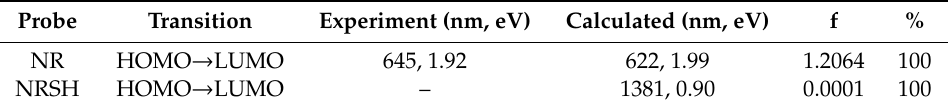
Table 1. Calculated fluorescence wavelengths ( λ fluo ), oscillator strengths ( f ), molecular orbital transition contributions to the fluorescence emission spectra and experimental data for the S 0 → S 1 excited states of NR and NRSH